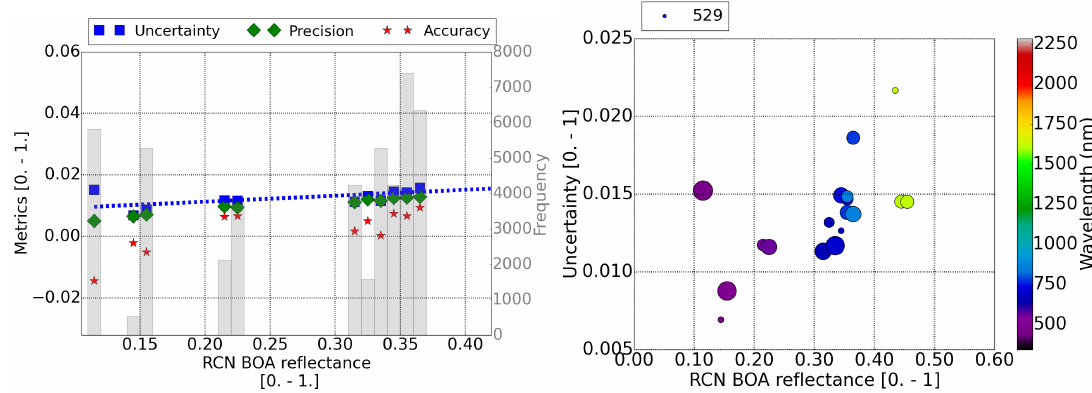
Figure 6. ( Left ) Distribution of the accuracy, precision, and uncertainty of Sentinel-2 surface reflectance as a function of the reference surface reflectance for the Gobabeb RadCalNet site. The number of pixels included in each bin are shown in the shadow histogram and on the right axis. Uncertainty fit is displayed as a dotted blue line. ( Right ) Uncertainty of the surface reflectance versus the reference value and the band central wavelength. The size of the points scales with the amount of pixels analyzed in each point. The amount of pixels considered for the smaller point is displayed in the legend. In both plots, the swir band (2250 nm), cirrus band (1380 nm), and water absorption bands at 940 nm have been